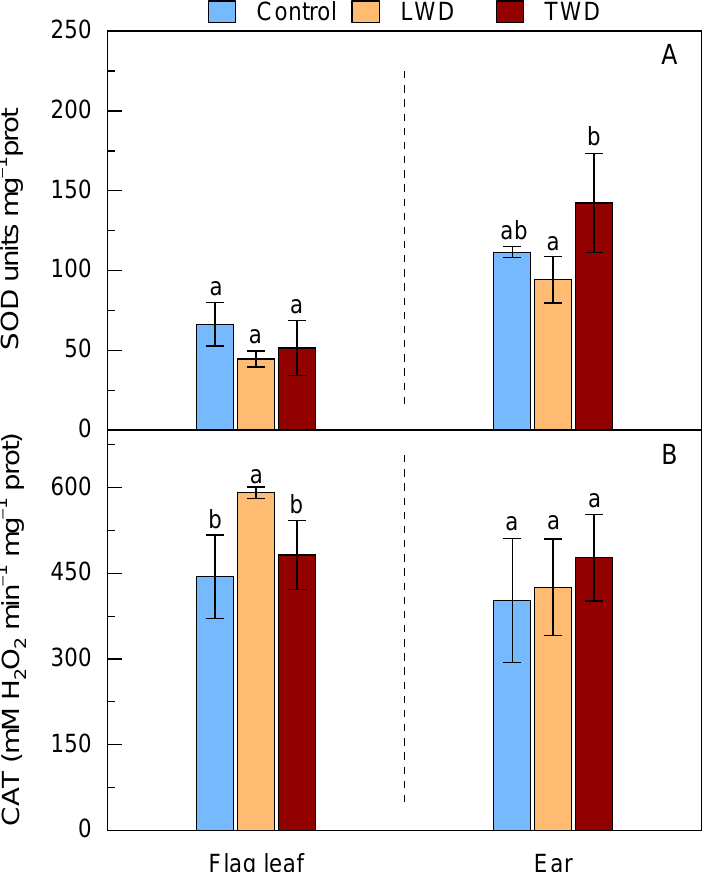
Figure 5. Effect of two water deficit treatments under combined elevated CO 2 and high temperature on superoxide dismutase (SOD) (Panel A ) and catalase (CAT) (Panel B ) activities in the flag leaves and ears of potted wheat. Legend is as described in Figure 2. Bars represent mean values ± SD. Different letters above the bars (a and b) indicate statistically significant differences among treatments for each organ after post-hoc test analyses ( p -value ≤ 0.05, n = 4, see Spreadsheet S1, Treatments).